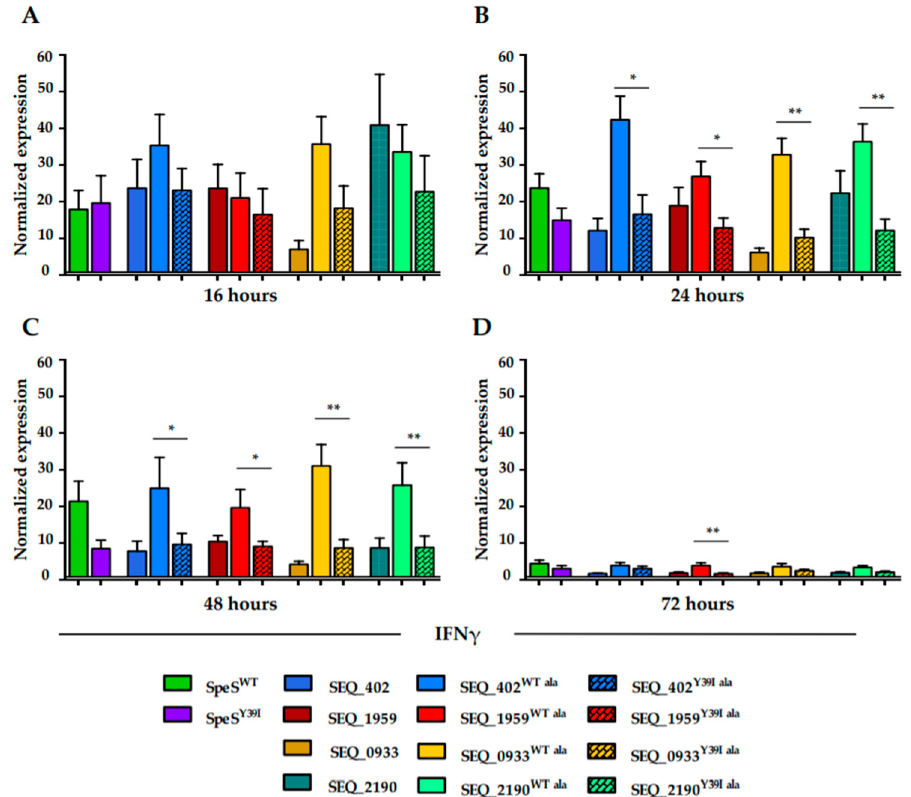
Figure 5. Levels of IFN γ (a proinflammatory cytokine) mRNA expression are reduced in PBMCs stimulated with SpeS Y39I and S. equi surface proteins fused to SpeS Y39I . A concentration of 4 × 10 6 cells was cultured in duplicate with 1 μ g/mL of PBS (control), SpeS WT , SpeS Y39I or the fusion proteins for ( A ) 16 h, ( B ) 24 h, ( C ) 48 h and ( D ) 72 h. Samples were normalized against the housekeeping genes β -actin and GAPDH. Differences between the experimental samples and control samples were calculated. Results are from three different experiments where PBMCs from two different donors were used. Error bars represent SEM. * p ≤ 0.05, ** p ≤ 0.01.